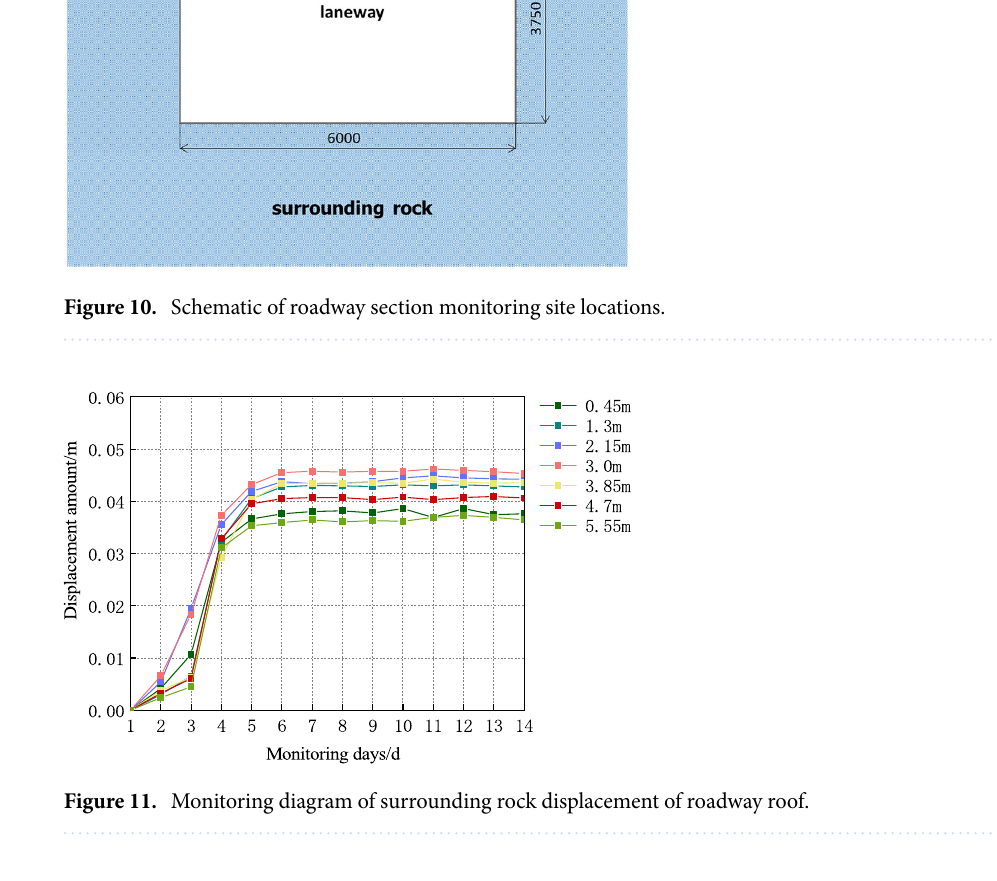
Mechanical parameters of surrounding